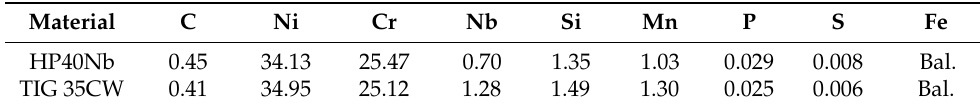
Table 1. Chemical composition of base metal and filler metal (wt %). Material